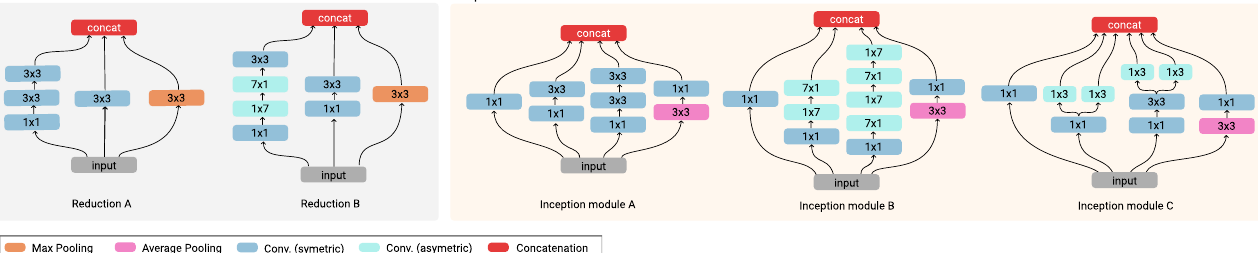
Figure 4. Modules of InceptionV3 architecture.